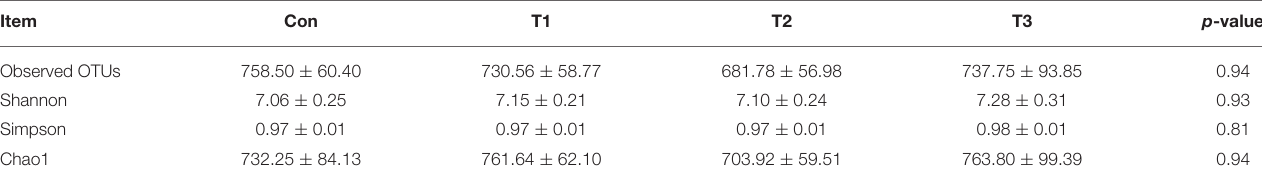
TABLE 7 | Observed OTUs and alpha diversity of colonic bacterial community of ducks with different dietary treatments ( n = 6). Item Con Observed OTUs